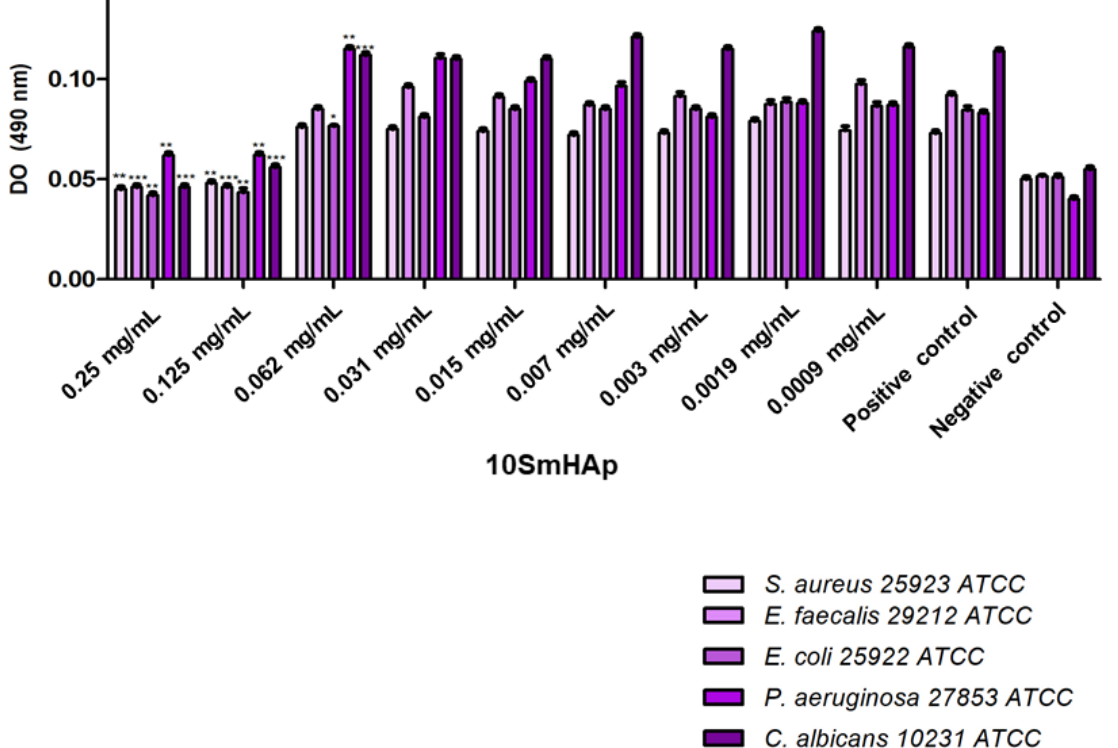
Figure 6. Graphic representation of the antibiofilm activity of 10SmHAp. * p < 0.05, ** p < 0.01 and *** p < 0.001 compared to